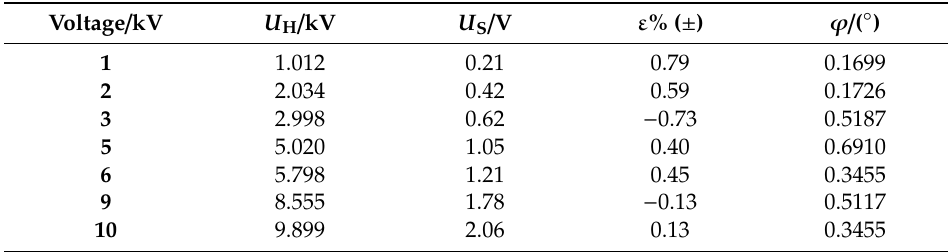
Table 3. Test results of steady-state